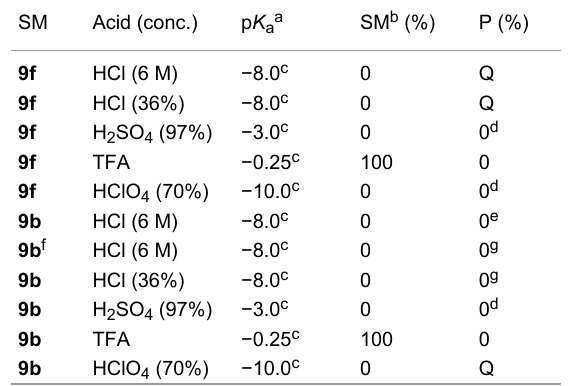
Table 2: Screening of the acidic catalyst for the PFB